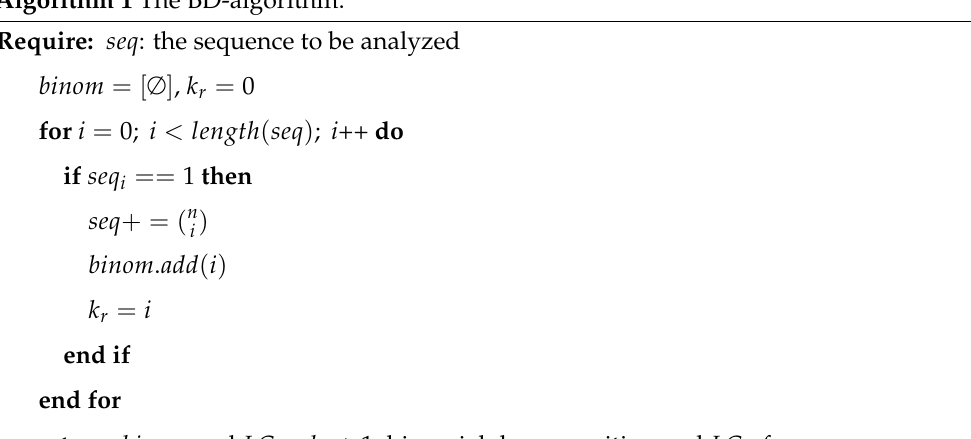
Algorithm 1 The BD-algorithm.